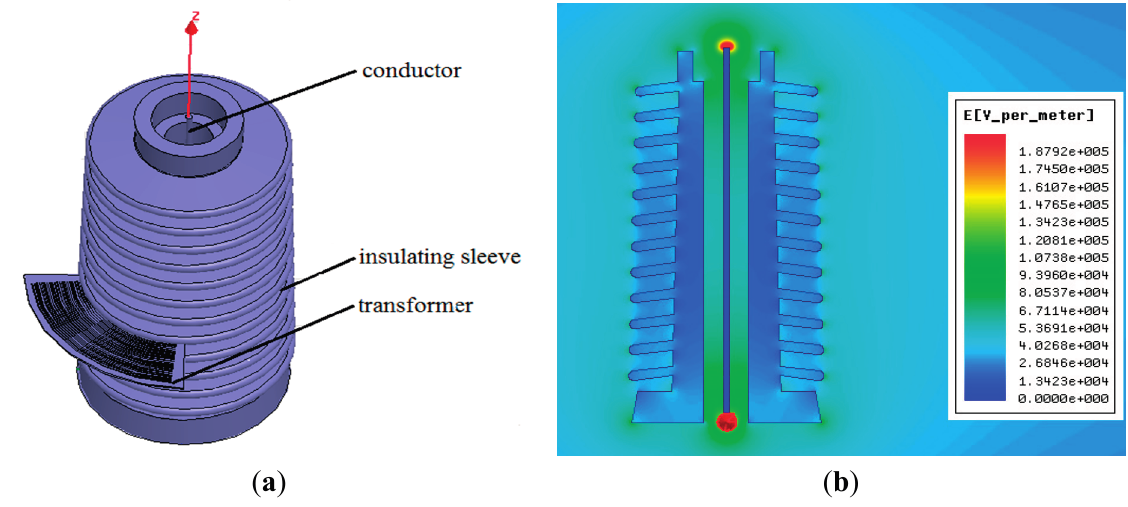
Figure 9. Simulation model. ( a ) Calculation model; ( b ) Electric field intensity distribution